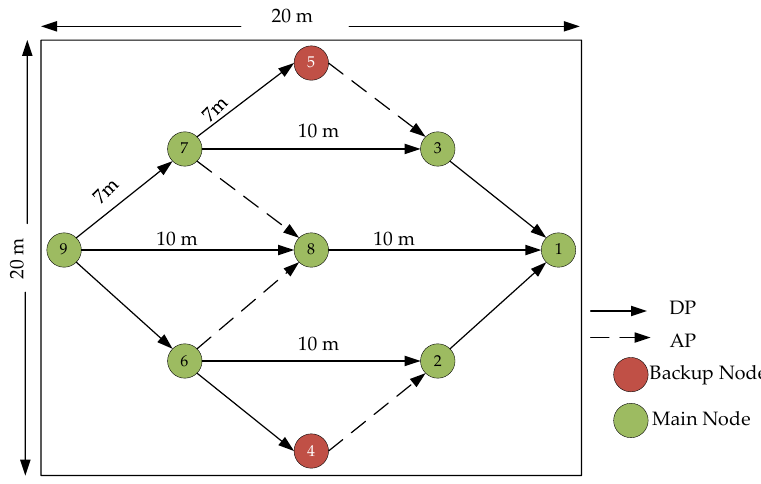
Figure 5. Proposed network structure of the